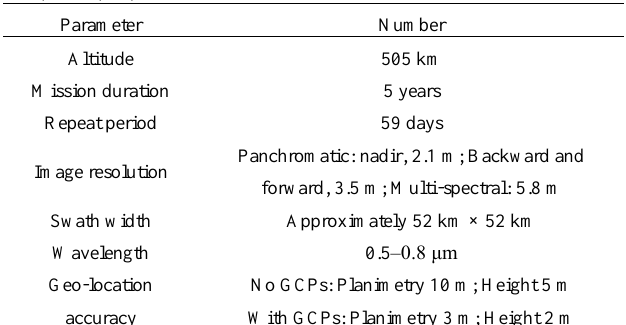
Table 1. The basic parameters of the ZY-3 satellite (Tang, X. et al, 2012; Li,